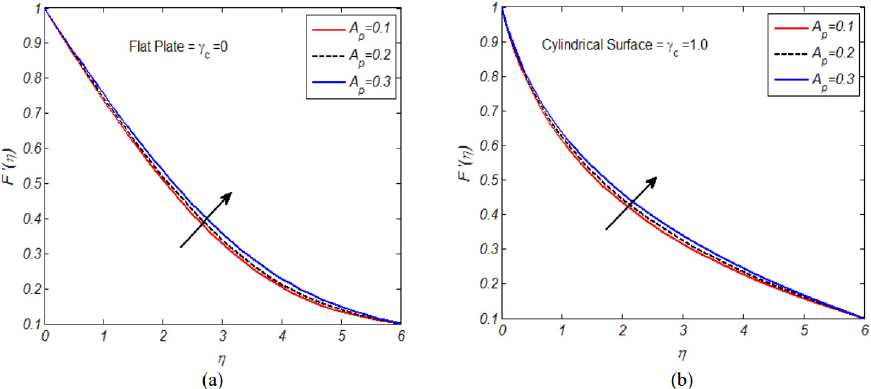
Figure 8. ( a ) Impact of p A on velocity at fl at surface; ( b ) Impact of p A on velocity at cylindrical surface. Figure 9a,b o ff er the in fl uence of the Casson fl uid parameter on Casson fl uid velocity. In detail, Figure 9a contributes the Casson fl uid parameter e ff ect on fl uid over a fl at sur- face while Figure 9b gives the impact of the Casson fl uid parameter on fl uid over a cylin- drical surface. We have seen that Casson fl uid velocity admits indirect relation towards fl uid parameter. The in fl uence of magnetic fi eld parameter on Casson fl uid velocity over a fl at and cylindrical surface is inspected. Figure 10a,b are evidence in this direction. In detail, Figure 10a reports the magnetic fi eld parameter impact on velocity, and we noticed that velocity decreases as the magnetic fi eld parameter increases. Similarly, Figure 10b o ff ers the impact of magnetic parameter on velocity over a stretching cylinder and we noticed that fl uid velocity shows decline trends for variation in magnetic fi eld parameter. For positive values of magnetic fi eld parameter, the Loren tz force increases, and, as a re- sult, resistance towards fl uid fl ow increases, which ultimately brings a decline in fl uid velocity over stretched surfaces. Table 11 o ff ers the performance particulars for both arti- fi cial neural networking models, and one can see that the developed models have the ca- pacity to predict the skin friction coe ffi cient values at both fl at and cylindrical surfaces with high accuracy. In the absence of an externally applied magnetic fi eld, heat genera- tion, and mass transfer, the present problem reduces to the research problem given by Hayat et al. [33]. The skin friction coe ffi cient (SFC) is considered a comparison quantity towards two important fl ow parameters, namely, the curvature parameter and the Casson fl uid parameter. Owing to Table 12, we found an excellent match.